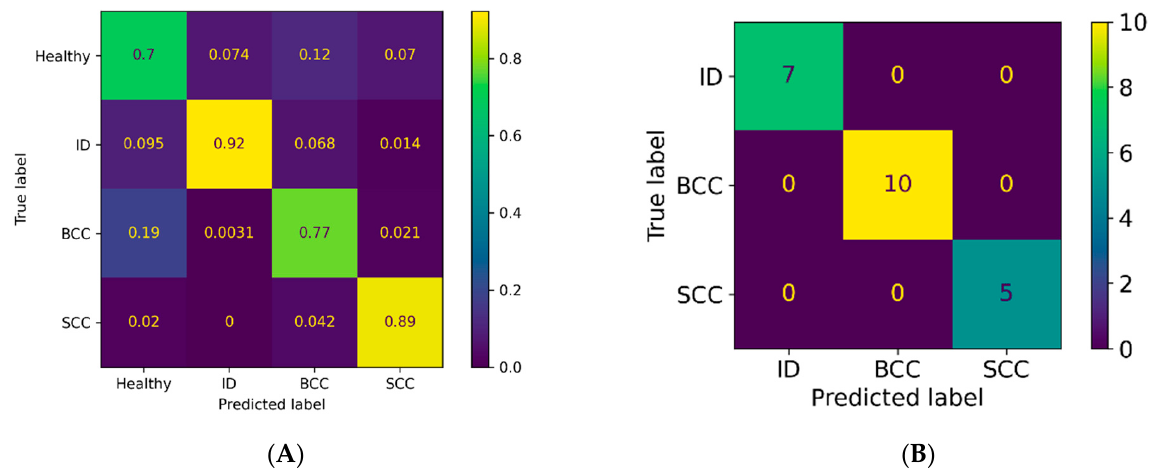
Figure 8. Confusion matrices presenting the PPVs for non-pigmented lesions in the ( A ) pixel-wise and ( B ) majority voting analyses.